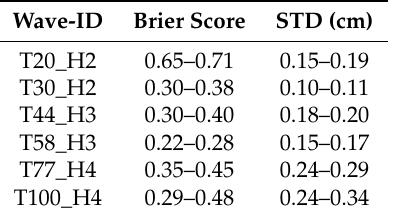
Table 2. Variation of Brier score [52] and standard deviation (STD) of all generated